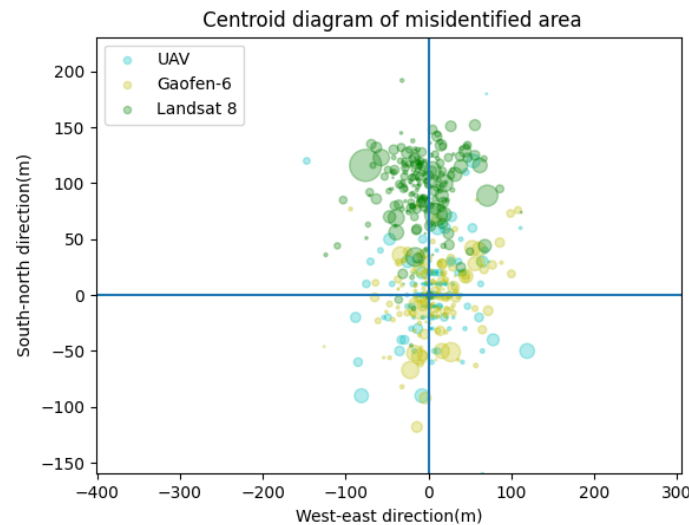
Figure 10. Schematic diagram of the location of each undetected area from the center of the landslide (The zero-point position is the mass center of the complete landslide area. The positions of the points are relative to the mass center of the complete landslide area. The size of the circle represents the area of the misidentified landslide).